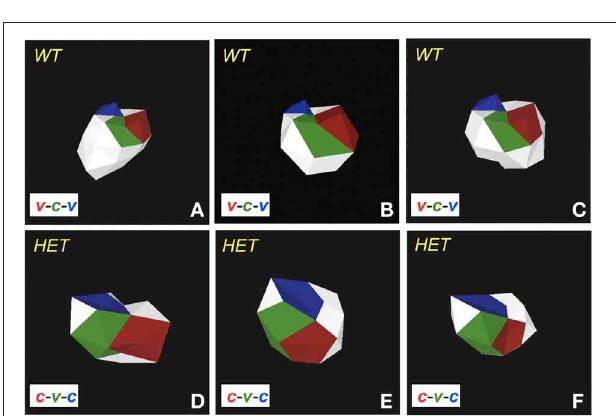
FIGURE 5 | Topographical data analysis with Plurigon . (A–C) Exemplary topologically color-coded, and dimensionally-reduced, plurigons from the WT data corpus. The three demonstrated plurigons demonstrate a structural tripartite motif of convex [(v) red]—concave [(c) green]—convex [(v) blue]. (D–F) Exemplary topologically color-coded, and dimensionally-reduced, plurigons from the HET data corpus. The three demonstrated plurigons demonstrate a structural tripartite motif of concave [(c) red]—convex [(v) green]—concave [(c)